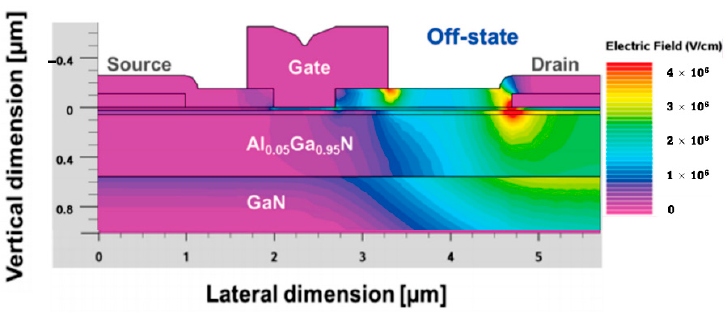
Figure 3. Electric field simulation in an off-state GaN HEMT with a drain bias of 300 V. Reprinted with permission from ref. [72]. Copyright 2017 MDPI.